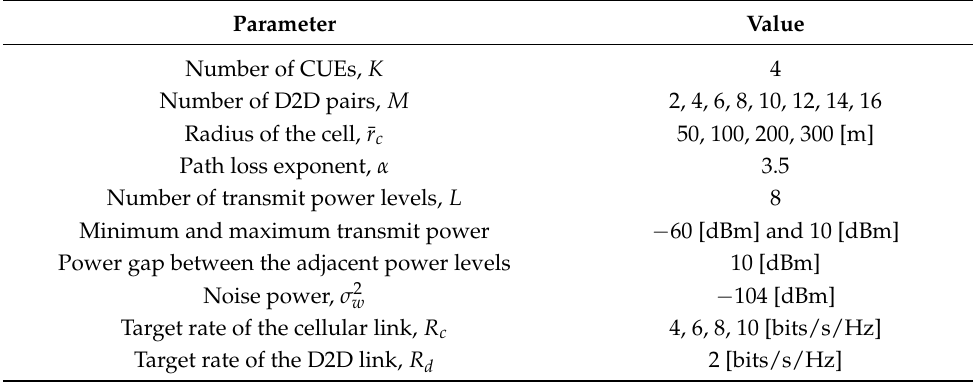
Table 1. Simulation parameters for D2D communications underlay cellular